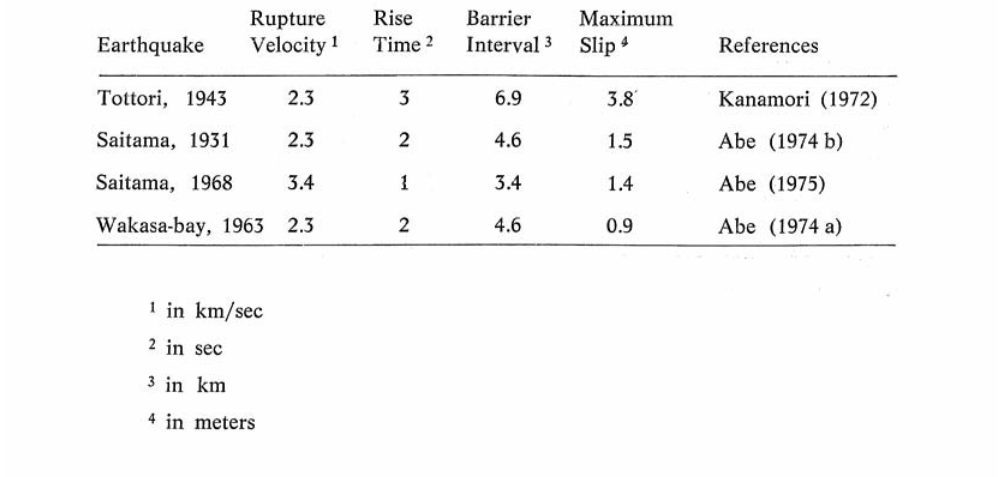
Table 3. Barrier interval and maximum slip estimated from rise